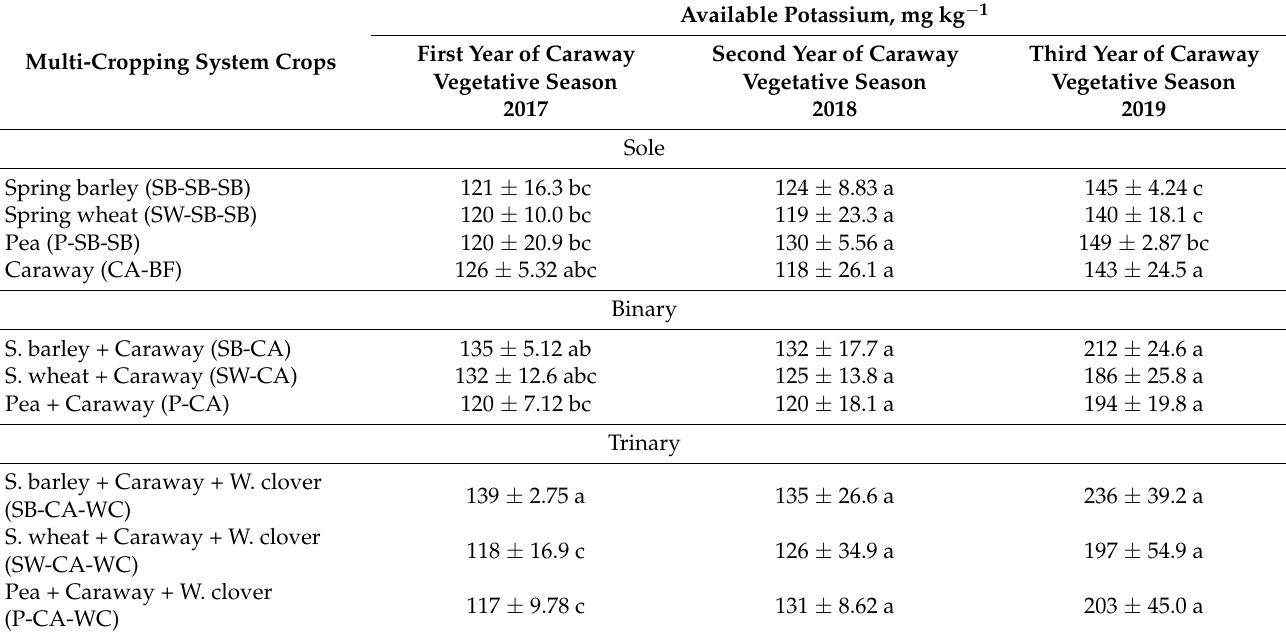
Multi-Cropping System Crops